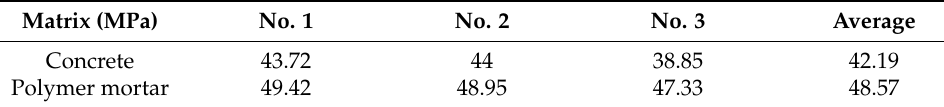
Table 2. Average compressive strength of concrete and polymer mortar.